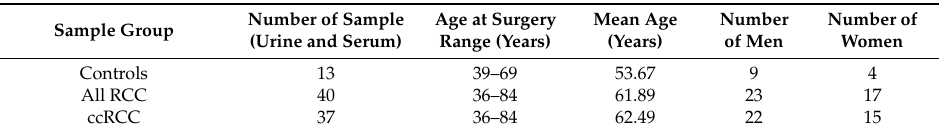
Table 1. Clinicopathologic characteristics of 53 patients with renal masses undergoing metabolomics analysis. RCC: Renal cell carcinoma. BMI: Body Mass